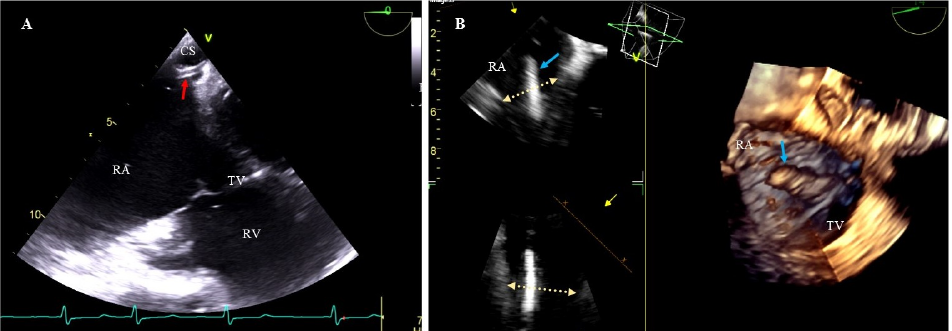
Figure 2. Additional use of TEE at new lead implantation during TLE. ( A ) 2D TEE images ‐ lower esophageal view. A catheter (red arrow) was inserted into the coronary sinus (CS) under X ‐ ray and TEE guidance. ( B ) 3D TEE images—mid ‐ esophageal view. The coil (blue arrow) protrudes into RA above the tricuspid valve level (white arrows). RA—right atrium, RV—right ventricle, TV—tricuspid valve.